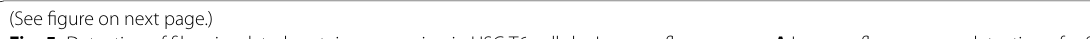
figure on next Fig. 5 Detection of fibrosis-related proteins expression in HSC-T6 cells by Immunofluorescence. A Immunofluorescence detection of α-SMA. B Immunofluorescence detection of collagen I. C Immunofluorescence detection of Fibronectin. DAPI (blue, nuclear stain) and antibodies to α-SMA, Collagen I and Fibronectin (red), immunofluorescence staining (magnification control group; # P < 0.05 vs TGF-β1 group; ## P < 0.01 vs TGF-β1